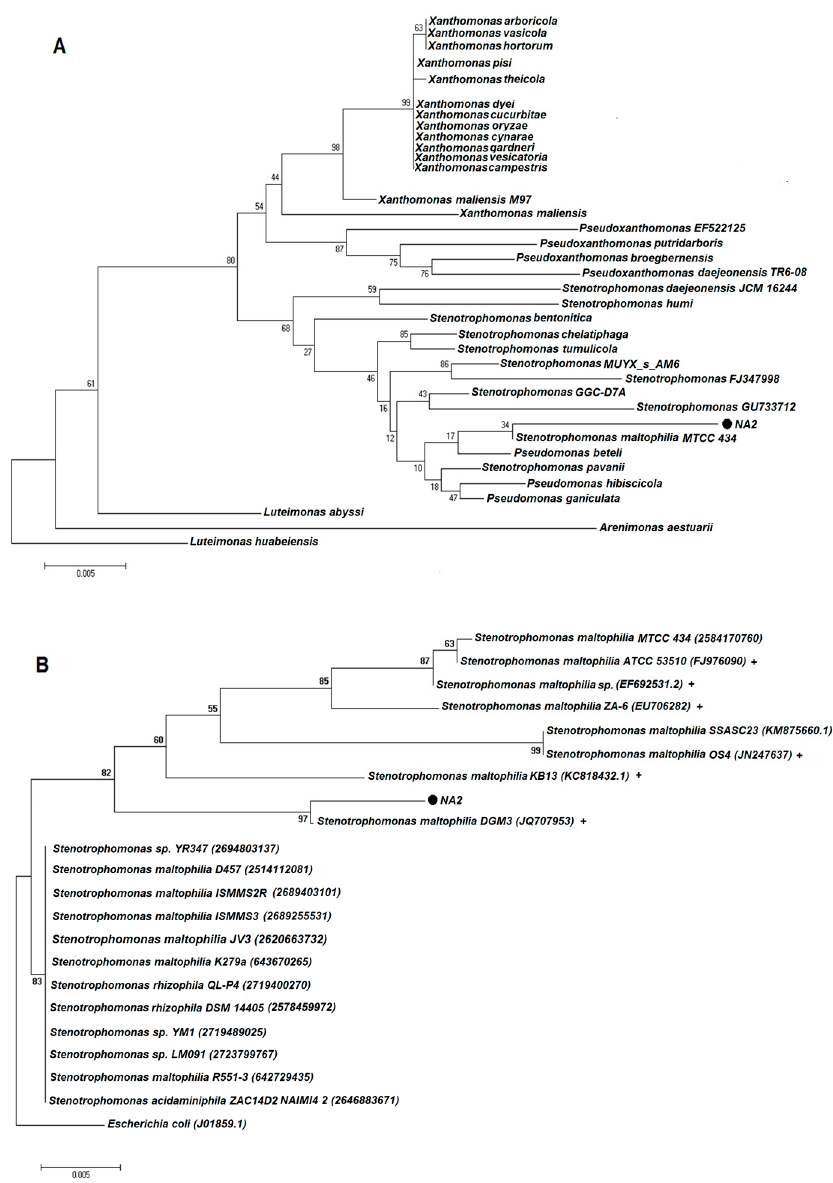
Figure 2. ( A ) Phylogenetic analysis resulting from the multiple alignment of 16S rRNA gene sequence of NA2 with those of other especies of the family Xanthomonadaceae found in the EzBioClould database; ( B ) Neighbor-joining phylogenetic analysis resulting from the multiple alignment of 16S rRNA gene sequence of NA2 with those of other bacterial strains of the genus Stenotrophomonas found in the GenBank and JGI database. The accession numbers of the strains are given in brackets. The scale bar corresponds to 0.05 substitution per nucleotide position. Experimental evidence (+).